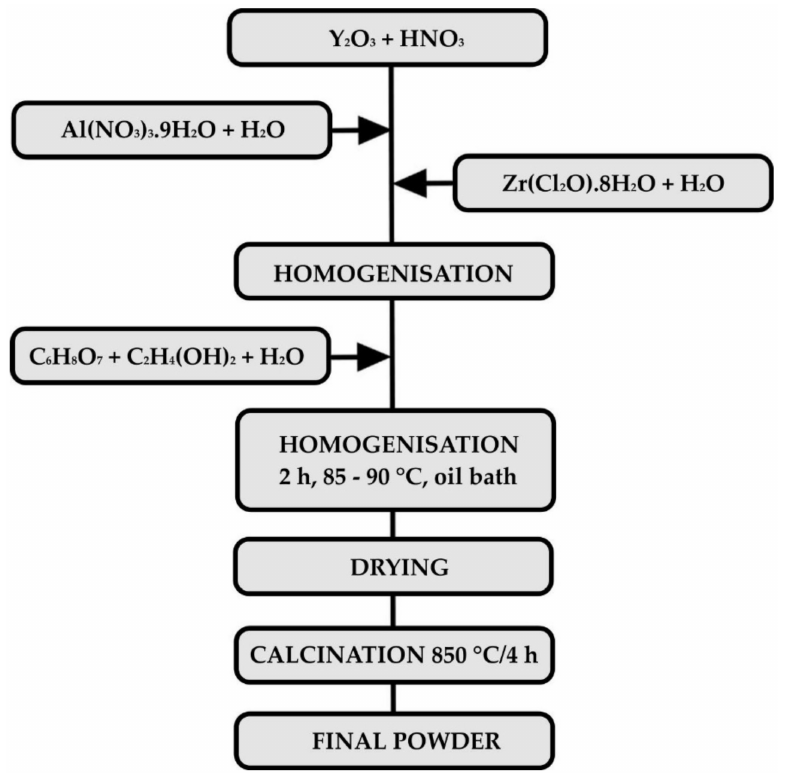
Figure 1. The flowchart of the processing of AYZ powder.